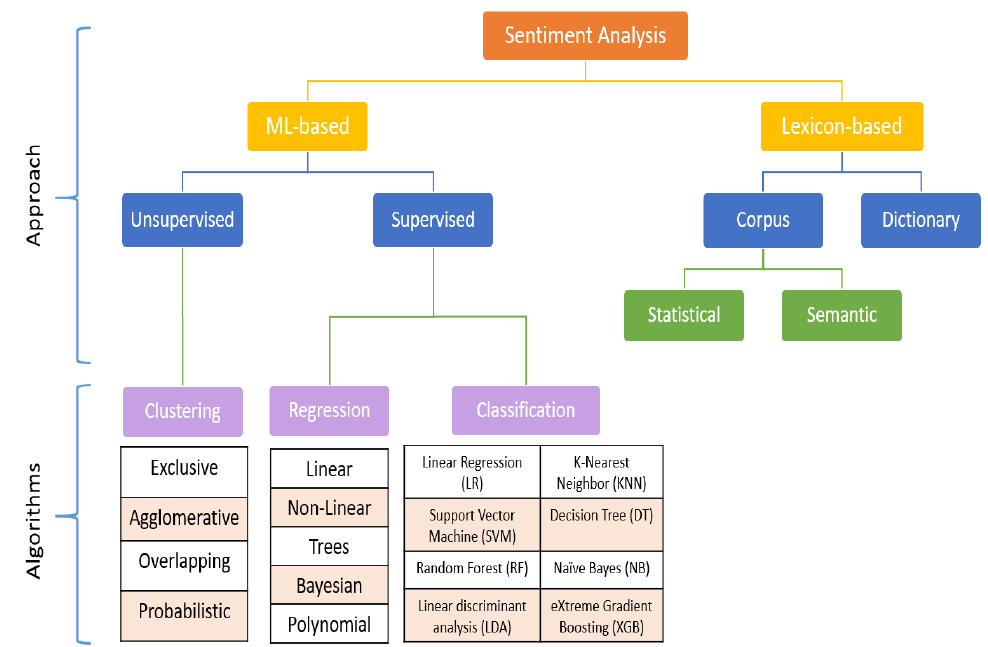
Figure 1. Sentiment analysis approaches and